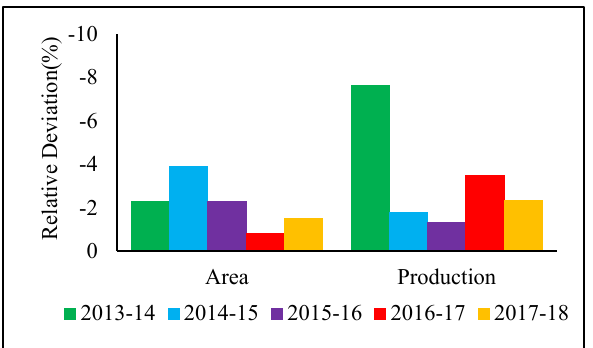
Figure 6. Showing classified image of wheat and mustard crop